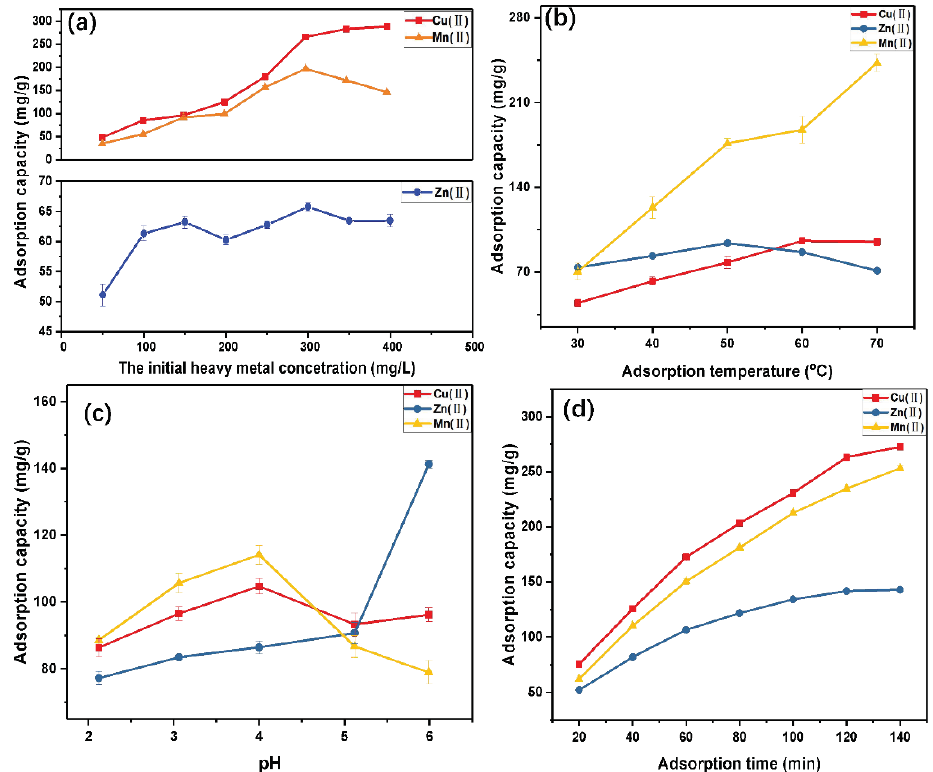
Figure 5. Effect of ( a ) the initial heavy metal ion (adsorbent quality: 0.0500 g; pH: 6.0; temperature: 60 °C; time: 120 min), ( b ) adsorption temperature (adsorbent quality: 0.0500 g; pH: 6.0; solution concentrations of 400 mg/g for Cu(II), 300 mg/g for Mn(II), and 300 mg/g for Zn(II); time: 120 min); ( c ) pH (adsorbent quality: 0.0500 g; temperatures for 60 °C for Cu(II), 70 °C for Mn(II), and 50 °C for Zn(II); solution concentrations of 400 mg/g for Cu(II), 300 mg/g for Mn(II), and 300 mg/g for Zn(II); time: 120 min); ( d ) adsorption time (adsorbent quality: 0.0500 g; temperatures of 60 °C for Cu(II), 70 °C for Mn(II), and 50 °C for Zn(II); solution concentrations of 400 mg/g for Cu(II), 300 mg/g for Mn(II), and 300 mg/g for Zn(II); pH values of 4.0 for Cu(II), 4.0 for Mn(II), and 6.0 for Zn(II)) of SC-